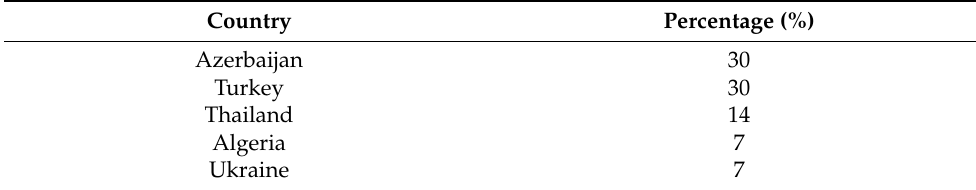
Table 5. Emerging worldwide digital radio markets and their